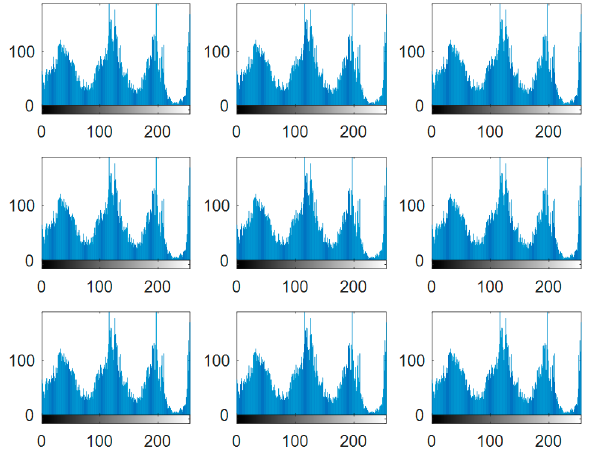
Figure 15. Encrypted versions of biometric faces in Figure 13 (i.e., from FERET dataset) for ( a ) CFR1 ( b ) CFR2, ( c ) homomorphic transform followed by salting and ( d ) homomorphic transform followed by random kernel convolution.